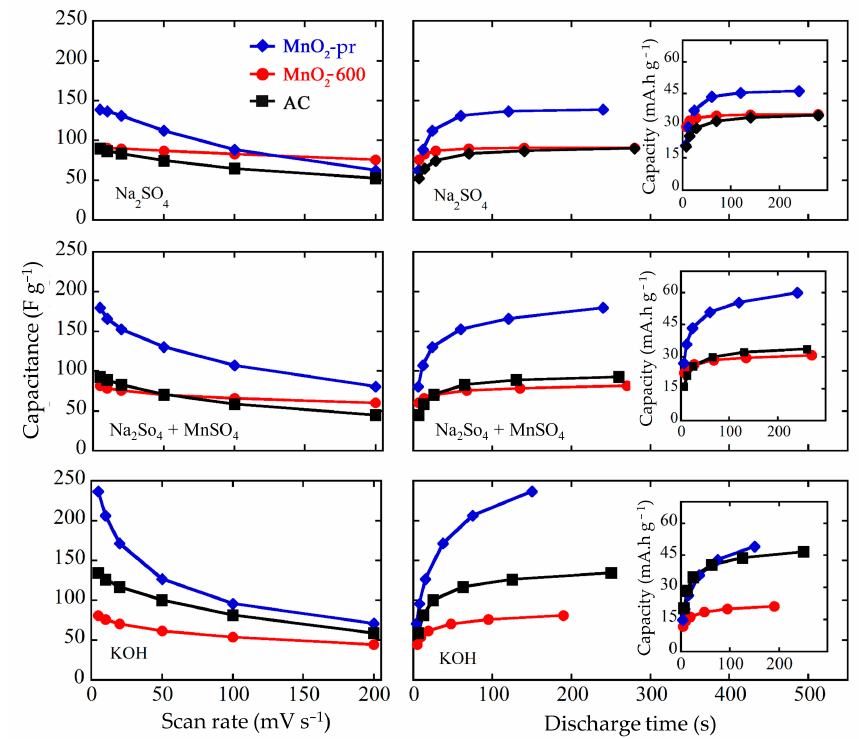
Figure 6. Specific capacitances of MnO 2 -pr; MnO 2 -600 and AC samples at 0–200 mV s − 1 scan rates ( left ) and vs. discharge time ( right ) in 0.5 M Na 2 SO 4 (Na 2 SO 4 ), 1 M KOH (KOH) and 0.5 M Na 2 SO 4 + 0.2 mM MnSO 4 (Na 2 SO 4 + MnSO 4 ) electrolytes. The insets show capacity values vs. discharge time.